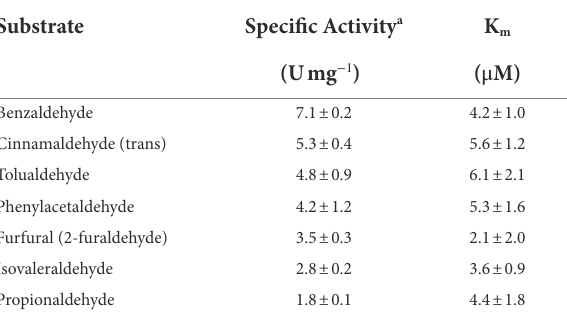
TABLE 2 Aldehyde oxidation activities of